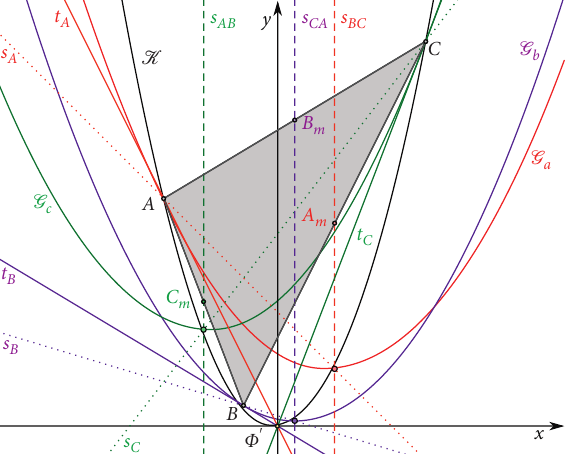
ABC . Visualization of the statement of Theorem 4.